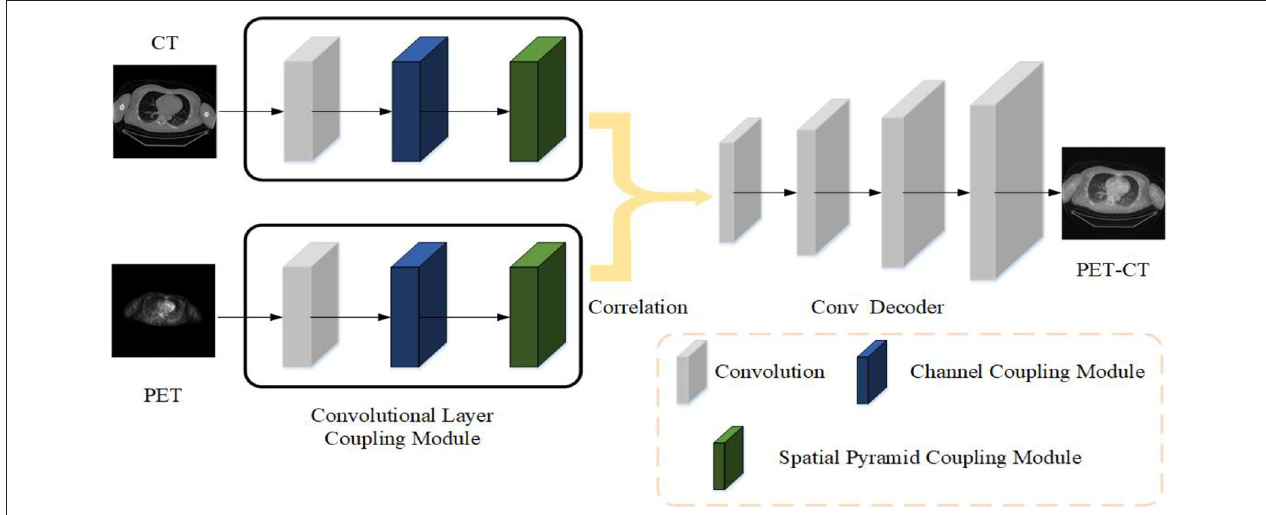
FIGURE 1 | The strategy of the proposed medical image fusion method. The source images first feed into encoder composed of CLCM to extract feature. Then two modality features are fused by cross correlation layer. Finally, the fused PET-CT image is reconstructed through the deconvolutional decoder.